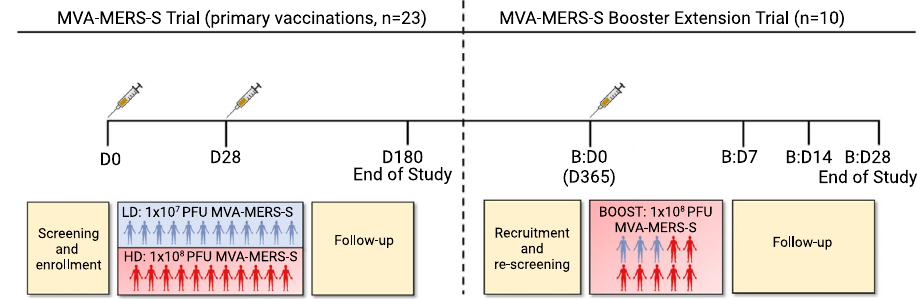
Fig. 1 Study design and trial pro fi le. Twenty-three individuals completed a homologous primary immunization with two vaccinations (Day (D) 0 (D0) and D28) of either 1 × 10 7 plaque-forming units (PFU) (low dose (LD), blue) or 1 × 10 8 PFU MVA-MERS-S (high dose (HD), red), and were followed-up for 180 days, which concluded this part of the study (End of Study). Participants were invited to return for an additional third vaccination as a booster 1 year ±4 months after prime. 10 participants (3 from the LD, 7 from the HD group) were re-enrolled and received a dose of 1 × 10 8 PFU MVA-MERS-S. Safety and tolerability were assessed on Boost (B) Days (B:D) 0 (B:D0, baseline), B:D1, B:D3 (not depicted), B:D7, B:D14, and B:D28; humoral immunogenicity was assessed on B:D0, B:D7, B:D14, and B:D28 (End of Study). All 10 participants completed the extension trial and were included in the analyses. Created